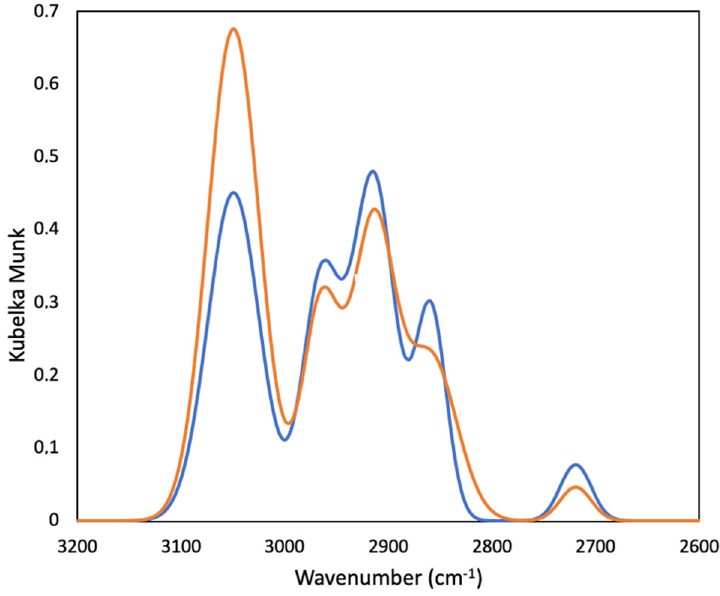
Figure 4. FTIR spectra of coke number 1 (red) and number 2 (blue).